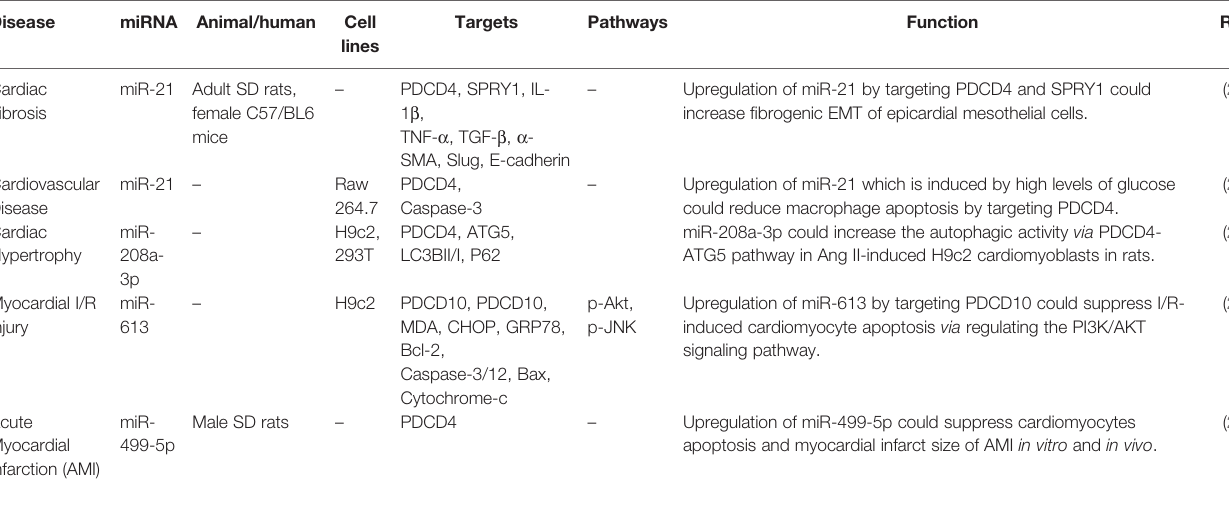
TABLE 1 | Interaction between miRNAs and PDCD in heart diseases. Disease miRNA